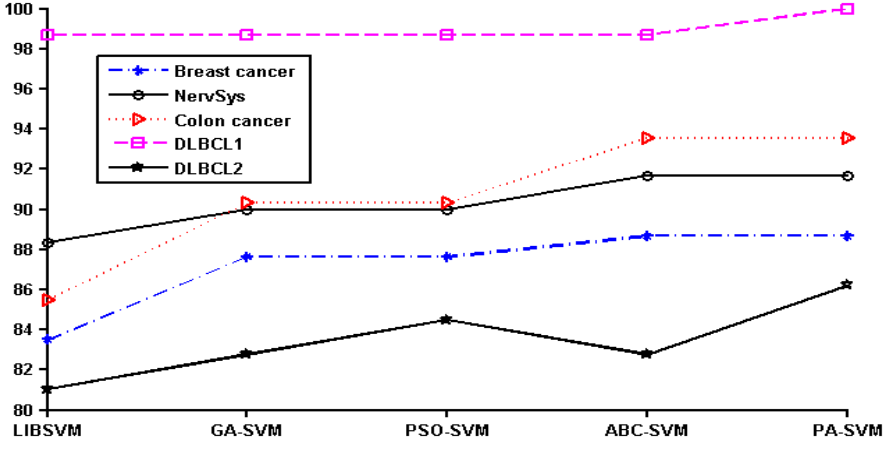
Figure 1. Cancer classification accuracy (%) of different methods.